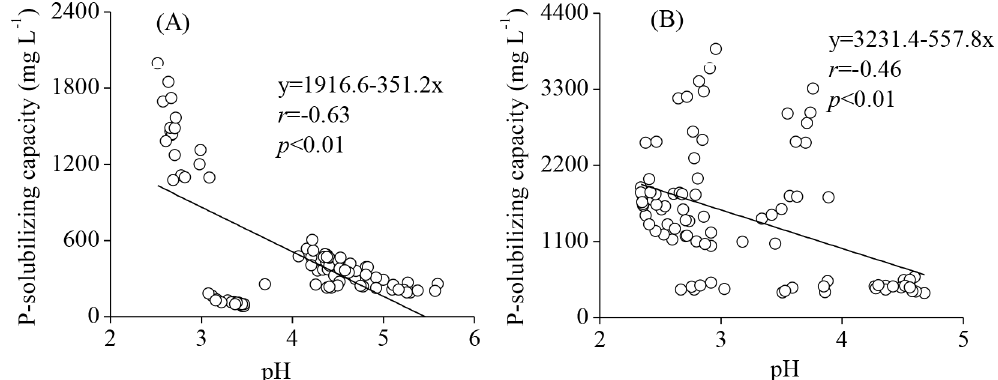
Fig 5. The Pearson’s correlations between the pH of the fermentation broth and P-solubilizing capacity of TalA-JX04 (A) and AspN-JX16